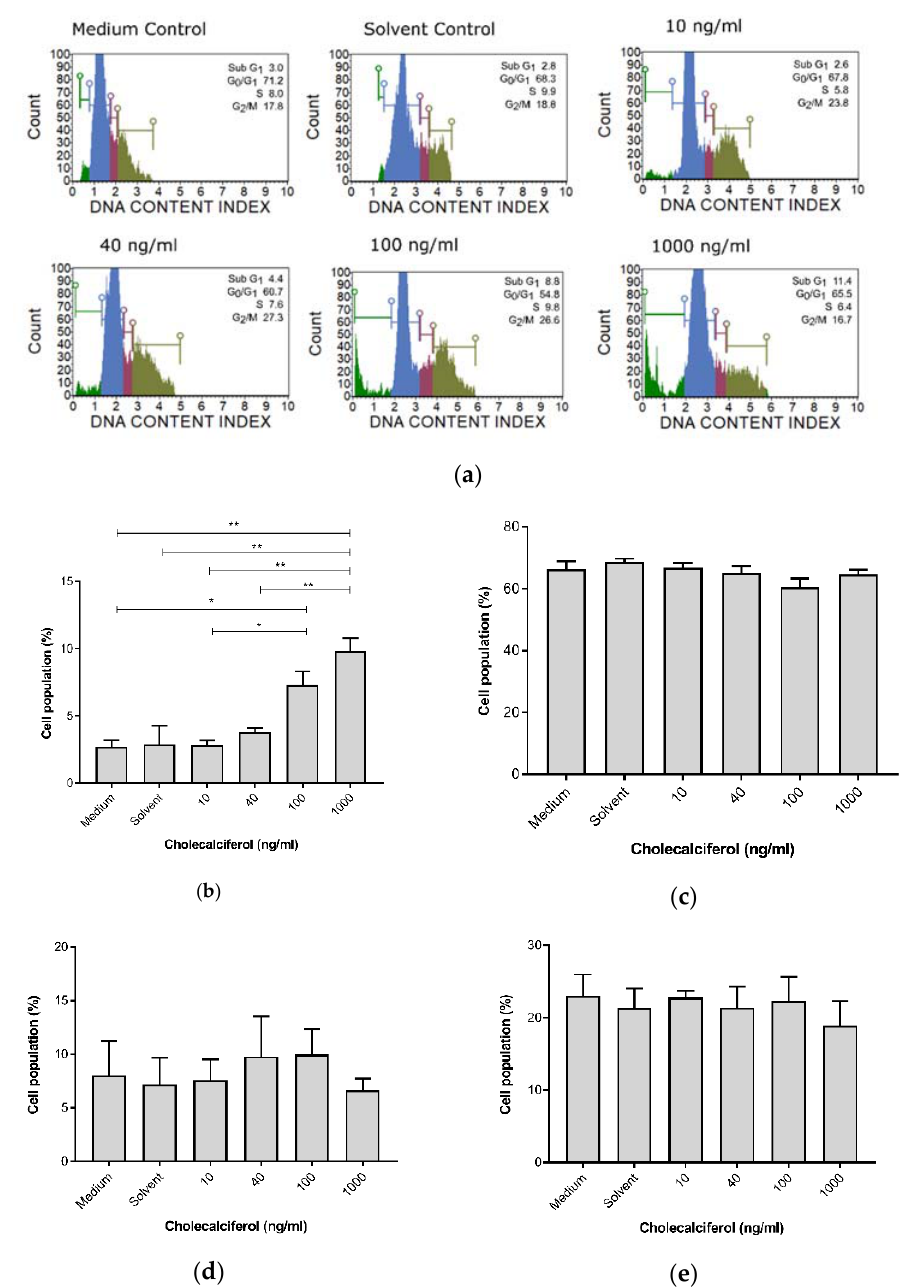
Figure 3. Cell cycle analysis of DNA content by the Muse™ Cell Cycle assay in the CaSki, control, and experimental cultures. ( a ) DNA distribution histogram of the CaSki, control, and experimental cultures at different phases of the cell cycle. ( b ) Cells in the sub ‐ G 1 phase, ( c ) G 1 /G 0 phase, ( d ) S phase, and ( e ) G 2 /M phase. Cholecalciferol treatment significantly increased the sub ‐ G 1 phases at the 100 and 1000 ng/mL treatments in comparison to the low ‐ dose treatments and control cultures. Values are expressed as mean ± SEM ( p < 0.05 was considered statistically significant). * p < 0.05; ** p < 0.01.